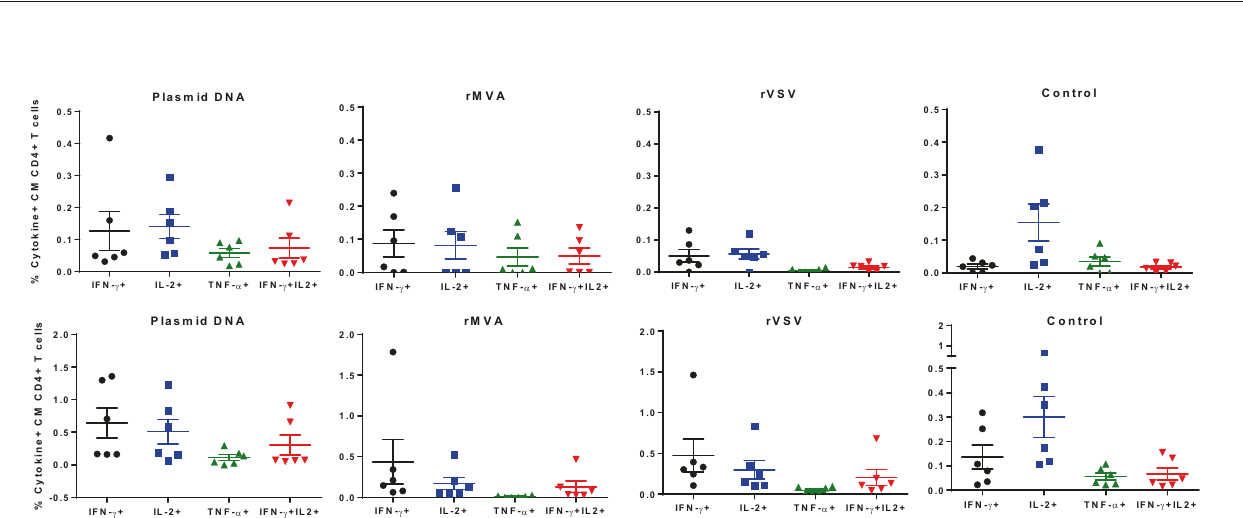
Fig. 2 Cytokine secretion pro fi le of the PBMC of the vaccinated monkeys as measured by ICS assay. Percentages of post-prime (upper panels) and post-protein boost (lower panels) cytokine-secreting CD4 + central/transitional memory T cells (T CM/TM ) were quanti fi ed in all four groups of monkeys following stimulation with C.1086 Env peptide pool. Percentages of IFN- γ (black circles), IL-2 (blue squares), TNF- α (green triangles), both IFN- γ /IL-2 (red inverted triangles) secreting T CM/TM CD4 + T cells are shown for individual monkeys for each vaccine group with mean and